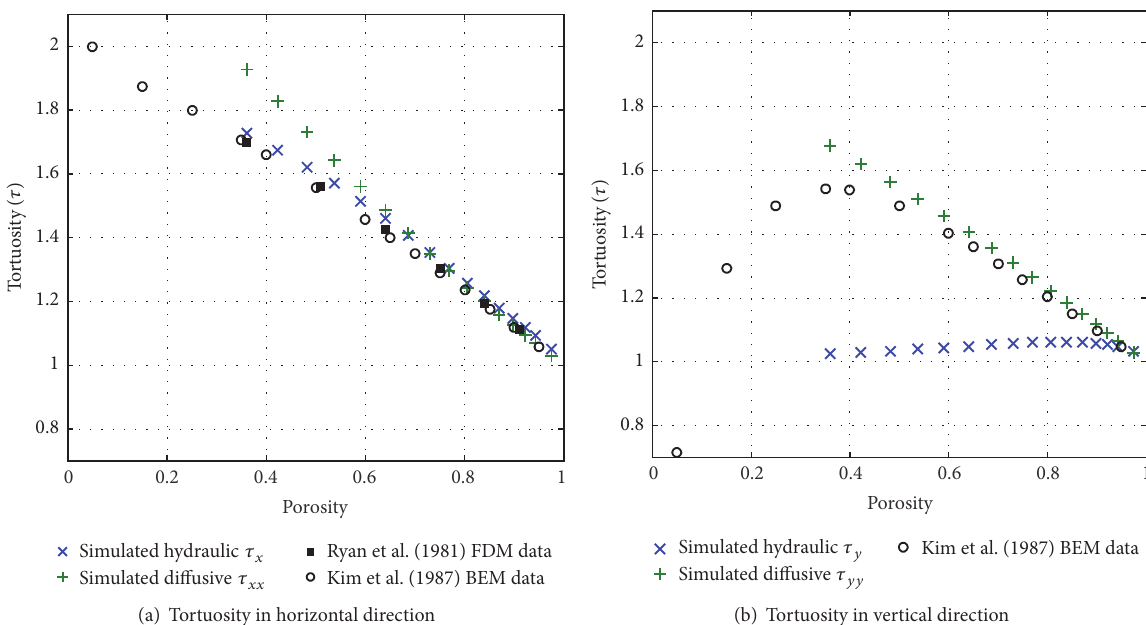
Figure 13: Tortuosity-porosity trends for staggered-array of squares. Simulated data is plotted against (diffusive) data from literature that employed finite difference (FD) and boundary element (BE) methods. In this geometry, hydraulic tortuosity in the 𝑦 direction is a weak function of porosity.